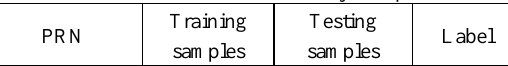
Table 1. Classification accuracy comparisons PRN